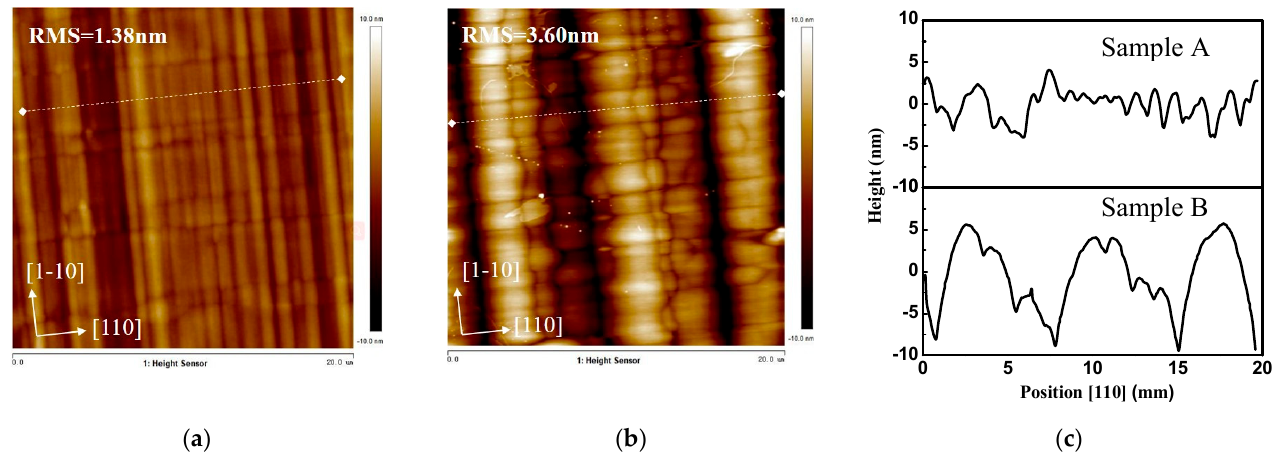
Figure 2. AFM images of extended wavelength InGaAs on InP substrate at a scanning area of 20 μ m × 20 μ m: ( a ) sample A (RMS: 1.38 nm); ( b ) sample B (RMS: 3.60 nm); ( c ) the line profile along [110] direction of sample A and sample B.